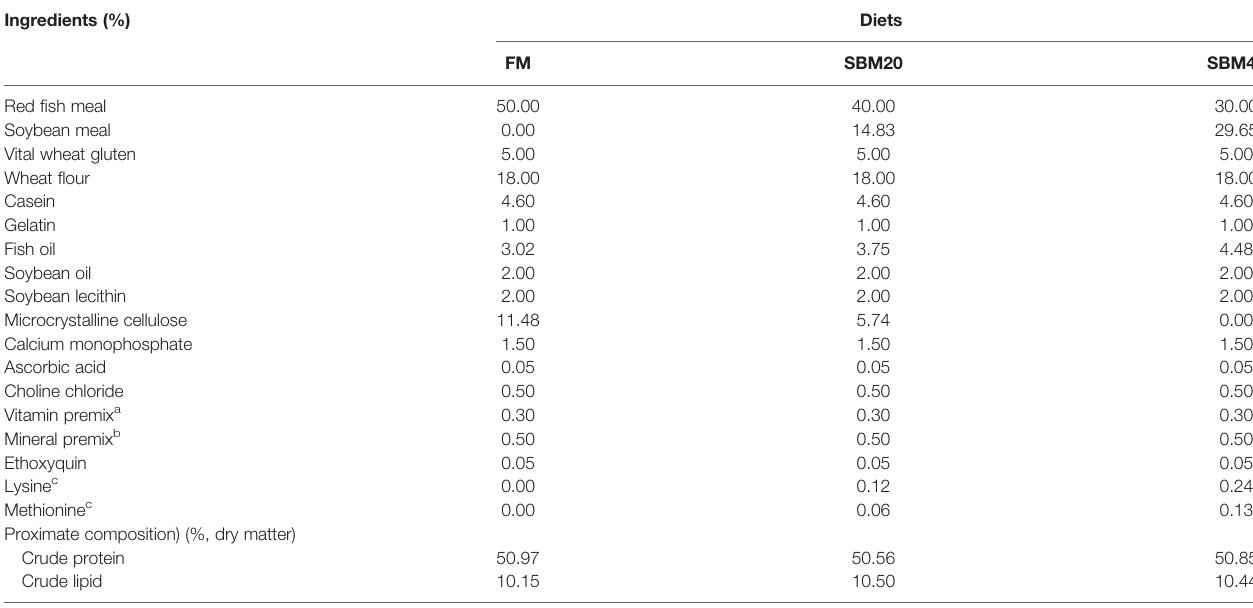
TABLE 1 | Formulation and proximate composition of the experimental diets (%, dry matter). Ingredients (%)